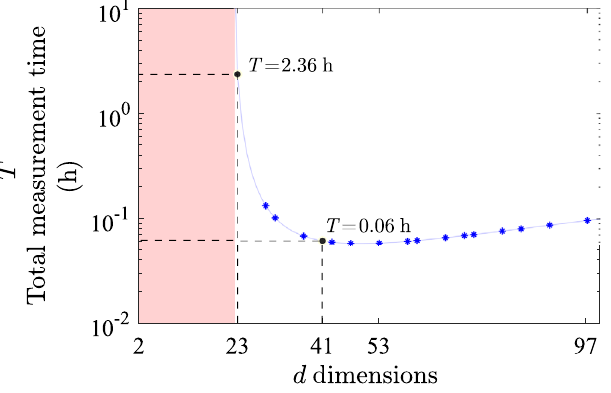
FIG. 5. Dependence of total measurement time ( T ) on dimen- sion ( d ). The total measurement time T (on log scale) required to violate the steering inequality by 10 standard deviations can be calculated from Eq. (C7) as a function of the prime dimension d for m ¼ d measurement settings, for a fixed one-sided heralding efficiency η ¼ 0 . 062 and noise parameter p ¼ 0 . 775 . The total time taken to obtain a steering violation using m ¼ 23 measure- ment settings in dimension d ¼ 23 is 2 orders of magnitude larger than that with m ¼ d ¼ 41